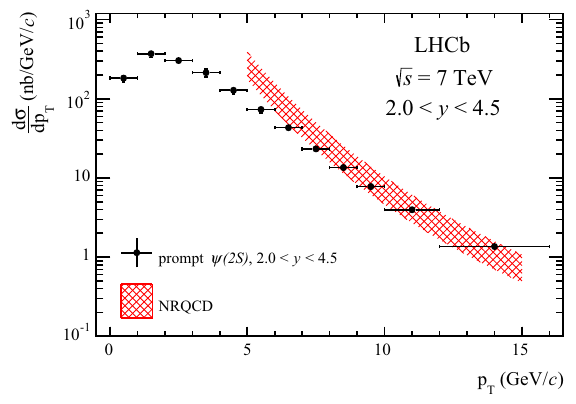
Fig. 7 Differential production cross-section of prompt ψ( 2 S ) as a function of p T in the range 2 . 0 < y < 4 . 5. The results are compared with the NRQCD calculations [4]. The error bars include statistical and systematic uncertainties added in quadrature